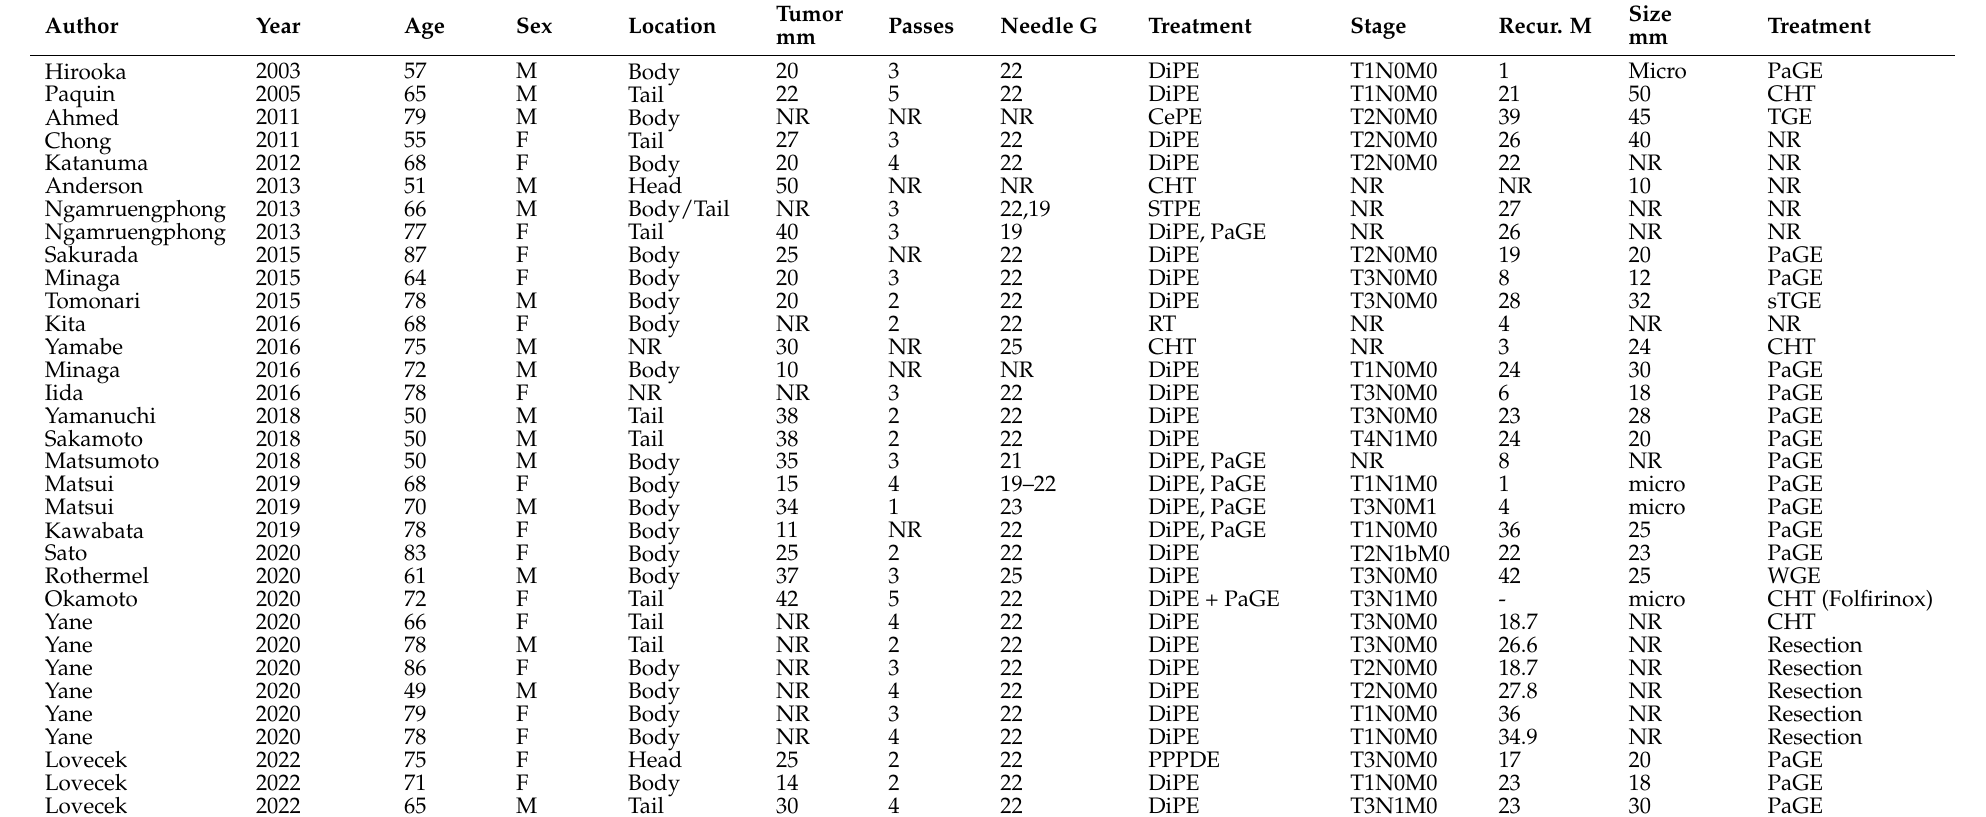
Table 3. Reported cases of needle tract seeding metastasis after EUS-FNA for pancreatic